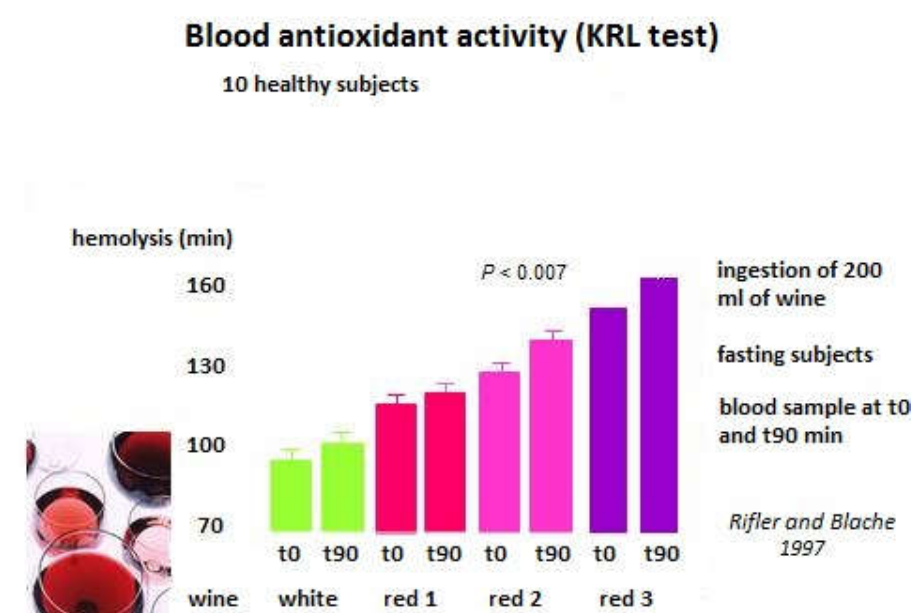
Figure 6. Blood antioxidant activity in healthy subjects drinking wine.